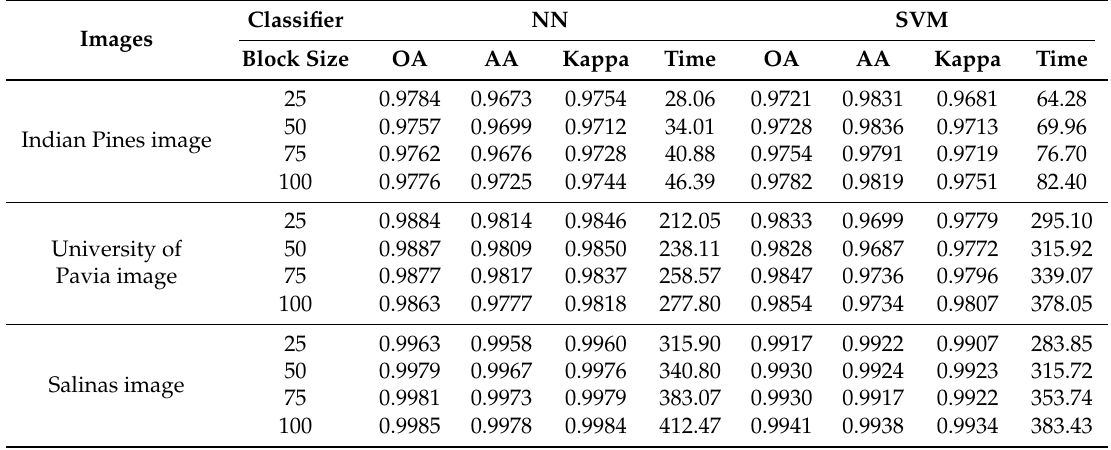
Table 7. Classification accuracy of the BLRDA method with different block